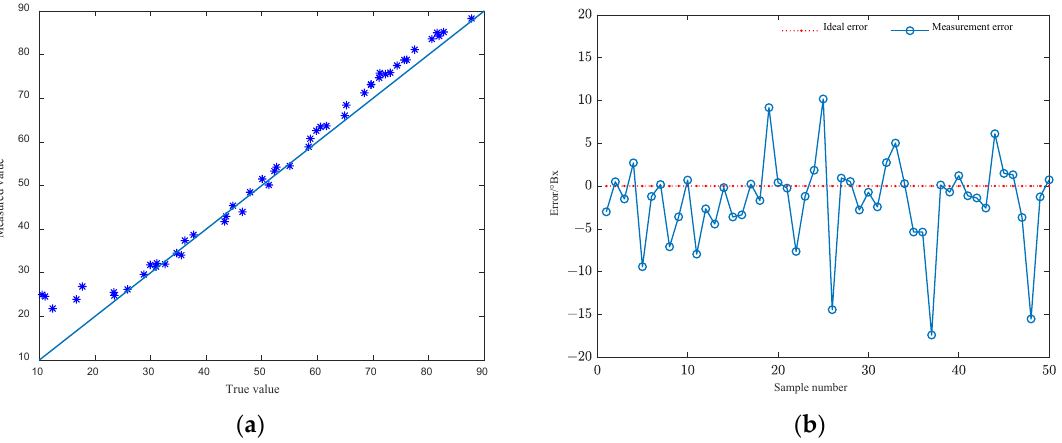
Figure 9. Measurement results of syrup brix based on SVR in the independent test set. ( a ) Measure- ment results of brix; ( b ) Measurement errors of brix.